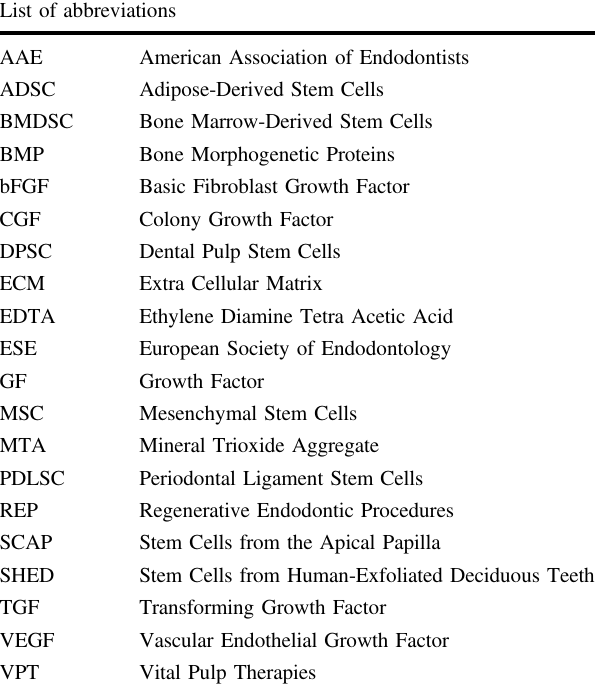
Table 1 List of